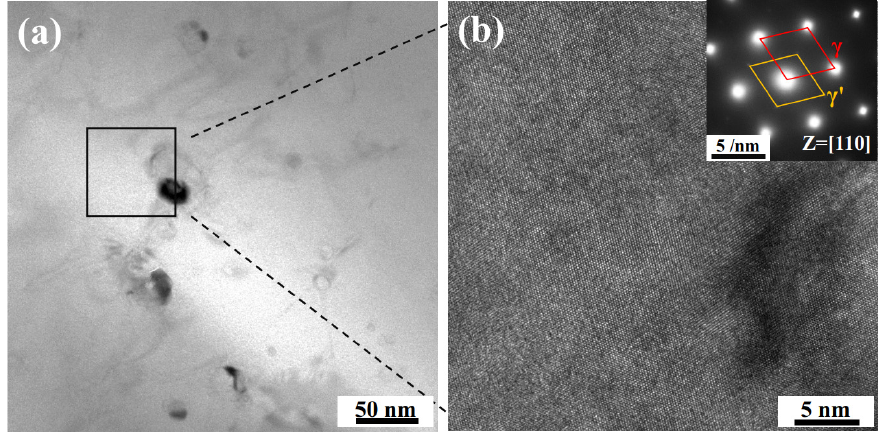
Figure 3. ( a ) Bright-field STEM image of FGH96 sample matrix and precipitations. ( b ) The corre- sponding SAED pattern of the region.